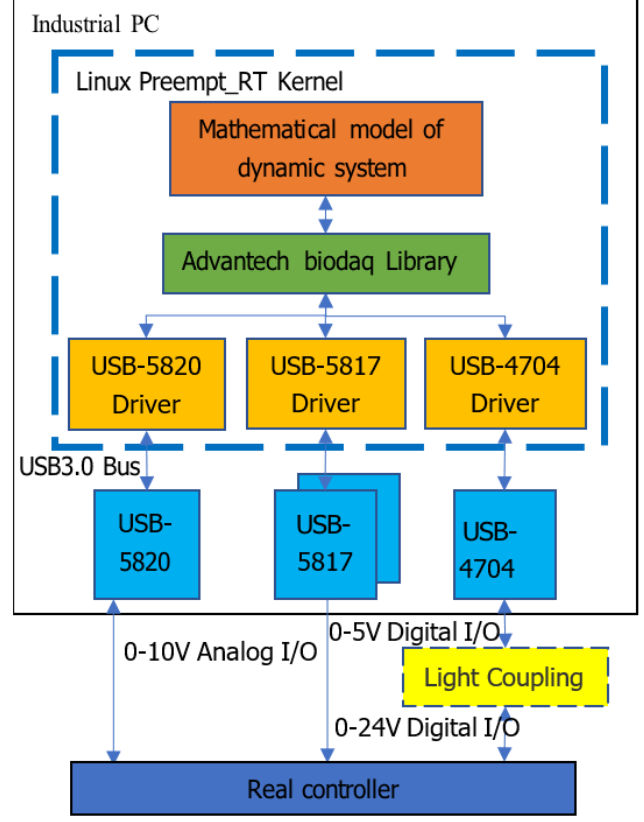
Figure 5. Hardware and software architecture of the HIL simulation system.